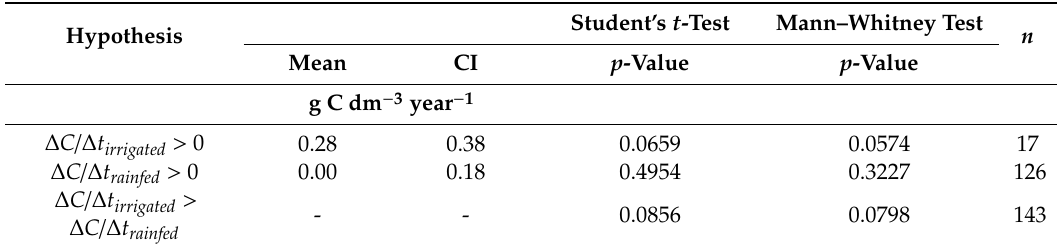
n : number of ∆ C / ∆ t values evaluated. CI: 95% confidence